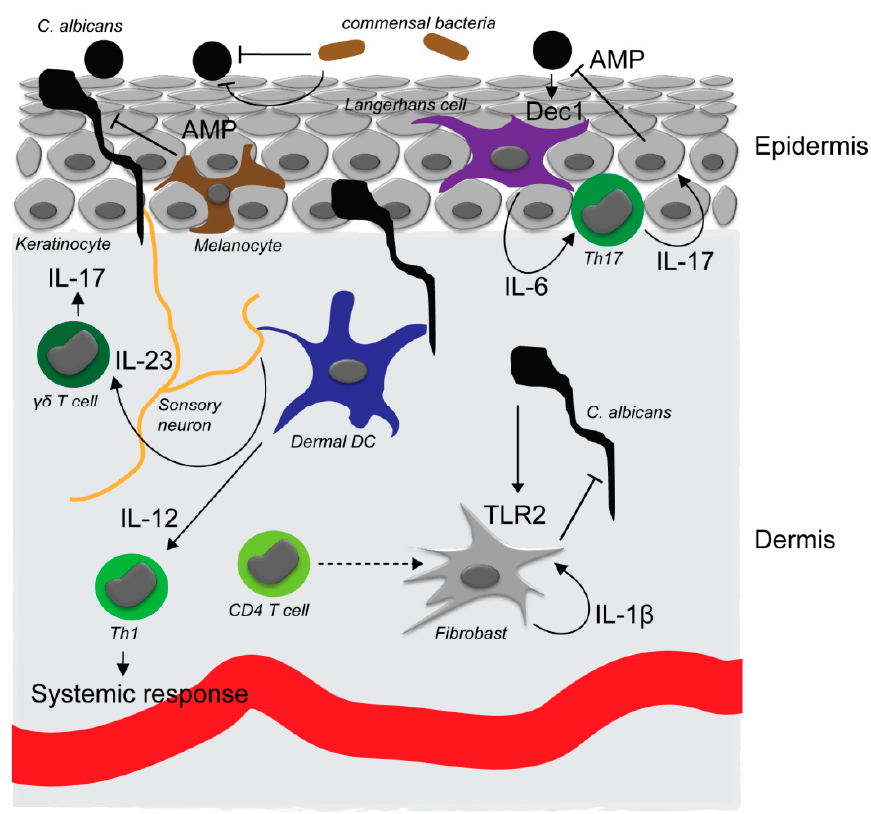
Figure 1. C. albicans interaction with the skin. In the commensal, noninvasive state, C. albicans exists in the yeast form on the tissue surface. Yeast cells can be detected through the dectin-1 receptor (Dec1) that is expressed by Langerhans cells in the epidermis. Activation of Langerhans cells (LCs) results in an interleukin-6 (IL-6)-dependent Th17 response, antimicrobial peptide production by keratinocytes and superficial antifungal defense. Commensal skin bacteria are also involved in preventing invasion of C. albicans into the skin by direct and indirect mechanisms. C. albicans invading the epidermis can moreover be detected by sensory neurons that promote IL-23 secretion by dermal dendritic cells and subsequent proliferation and IL-17 secretion of skin resident γδ T cells. Upon breaching of the epidermis, C. albicans is detected in the dermis by dermal dendritic cells which induce an IL-12-dependent Th1 response required for systemic immunity against the fungus. Dermal fibroblasts support direct antimicrobial defense in the dermis upon activation through TLR2 by C. albicans and IL-1 β secretion and auto-activation. Secretion of IL-1 β by dermal fibroblasts requires an additional yet unidentified signal from CD4 + T cells.